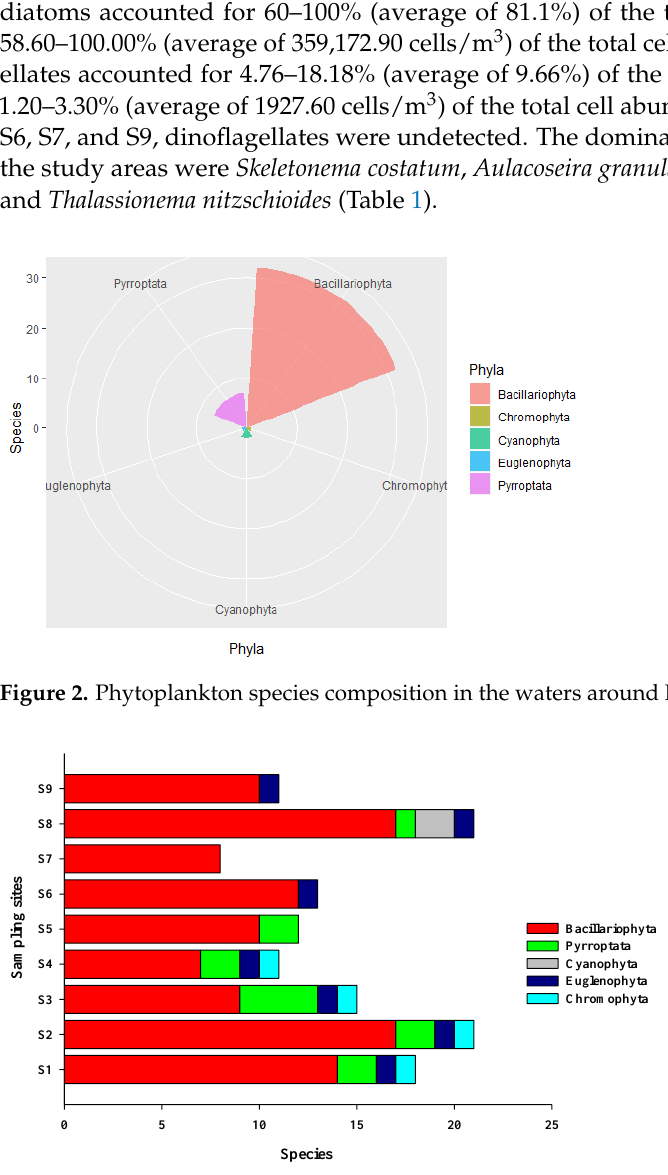
Figure 3. Phytoplankton species of different taxa detected in the different sampling sites. Table 1. Dominant phytoplankton species collected by net from the waters around Macau.